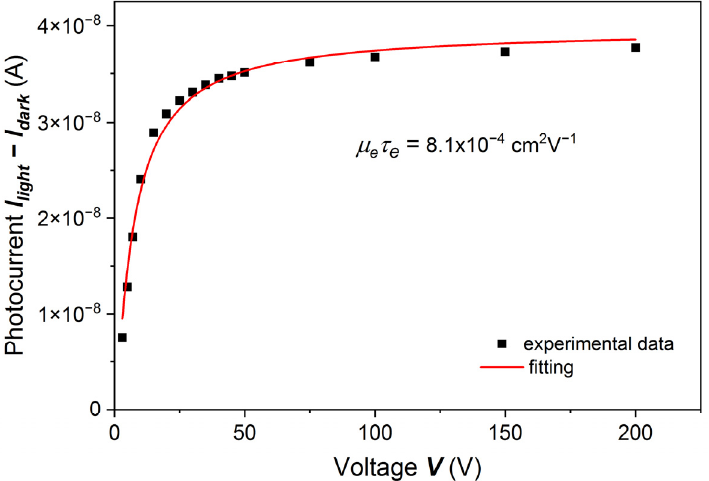
Figure 1. Room-temperature electron photocurrent as a function of a bias voltage for the Cd 0.95 Mn 0.05 Te:In sample etched with 10% HCl. The illuminating light energy was ħω = 1.590 eV (E g + 15 meV). The solid line is a fit with the Hecht equation. The value of the μ e τ e parameter is 8.1 × 10 − 4 cm 2 V − 1 with a standard error of 0.47 × 10 − 4 cm 2 V − 1 . The contacts were sputtered ~30 nm thick Au/Pd layers.